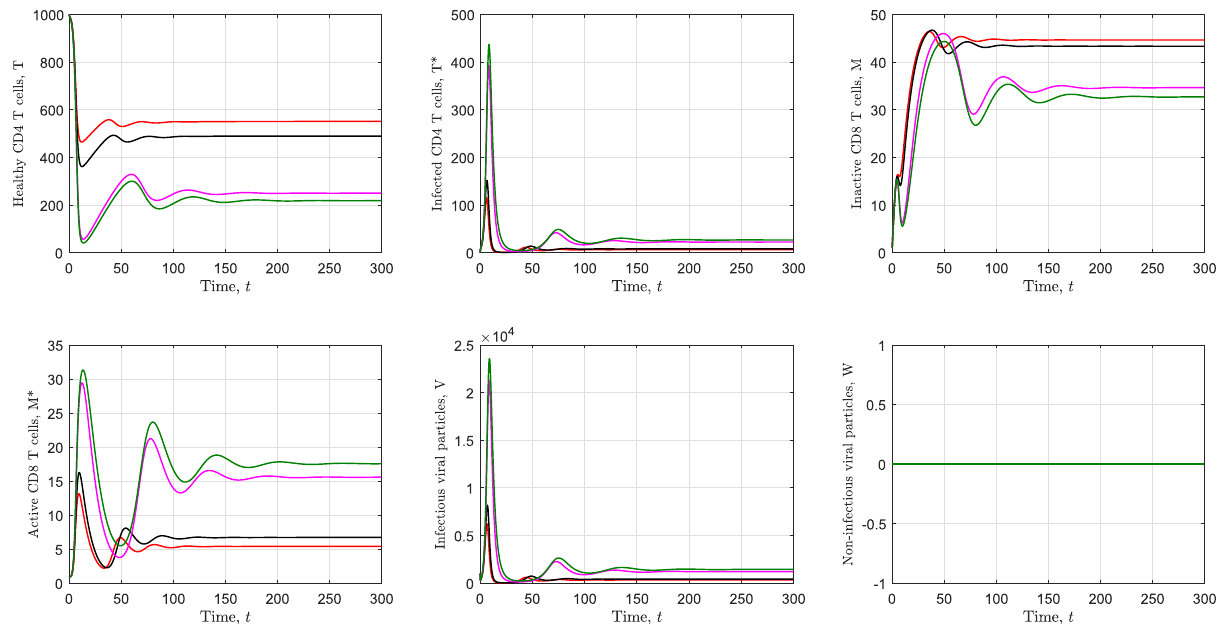
Figure 3. Simulations performed for the parameters according to the values from Table 2, varying the probability of active CD8 T cells eliminating the infected CD4 T cells γ , where γ = 9 × 10 − 2 (red), γ = 6 × 10 − 2 (black), γ = 5 × 10 − 3 (magenta) and γ = 2 × 10 − 3 (green). Fixed values were taken for the CD4 T cell infection probability, β = 2.5 × 10 − 5 , and ART use was not considered, thus, u i = 0, for i = 1,2. R 0 = 2.0280 in all the scenarios